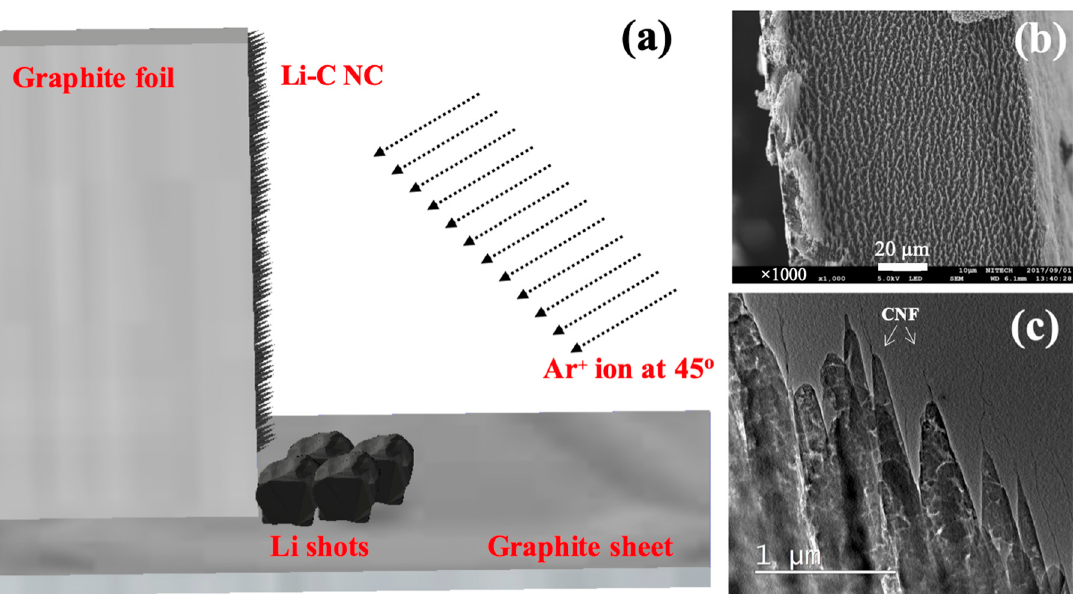
Figure 1. ( a ) Schematics showing sample setup for Li-C nanocomposite (NC) preparation. ( b ) Scanning electron microscope (SEM) image showing the top view of Li-C NC grown on the edge of graphite foil. ( c ) Low Mag transmission electron microscopy (TEM) image showing Li-C NC fabricated by Ar + ion irradiation at 700 eV. Carbon-based nanofibers (CNFs) grew on top of several conical structures, as exemplified by